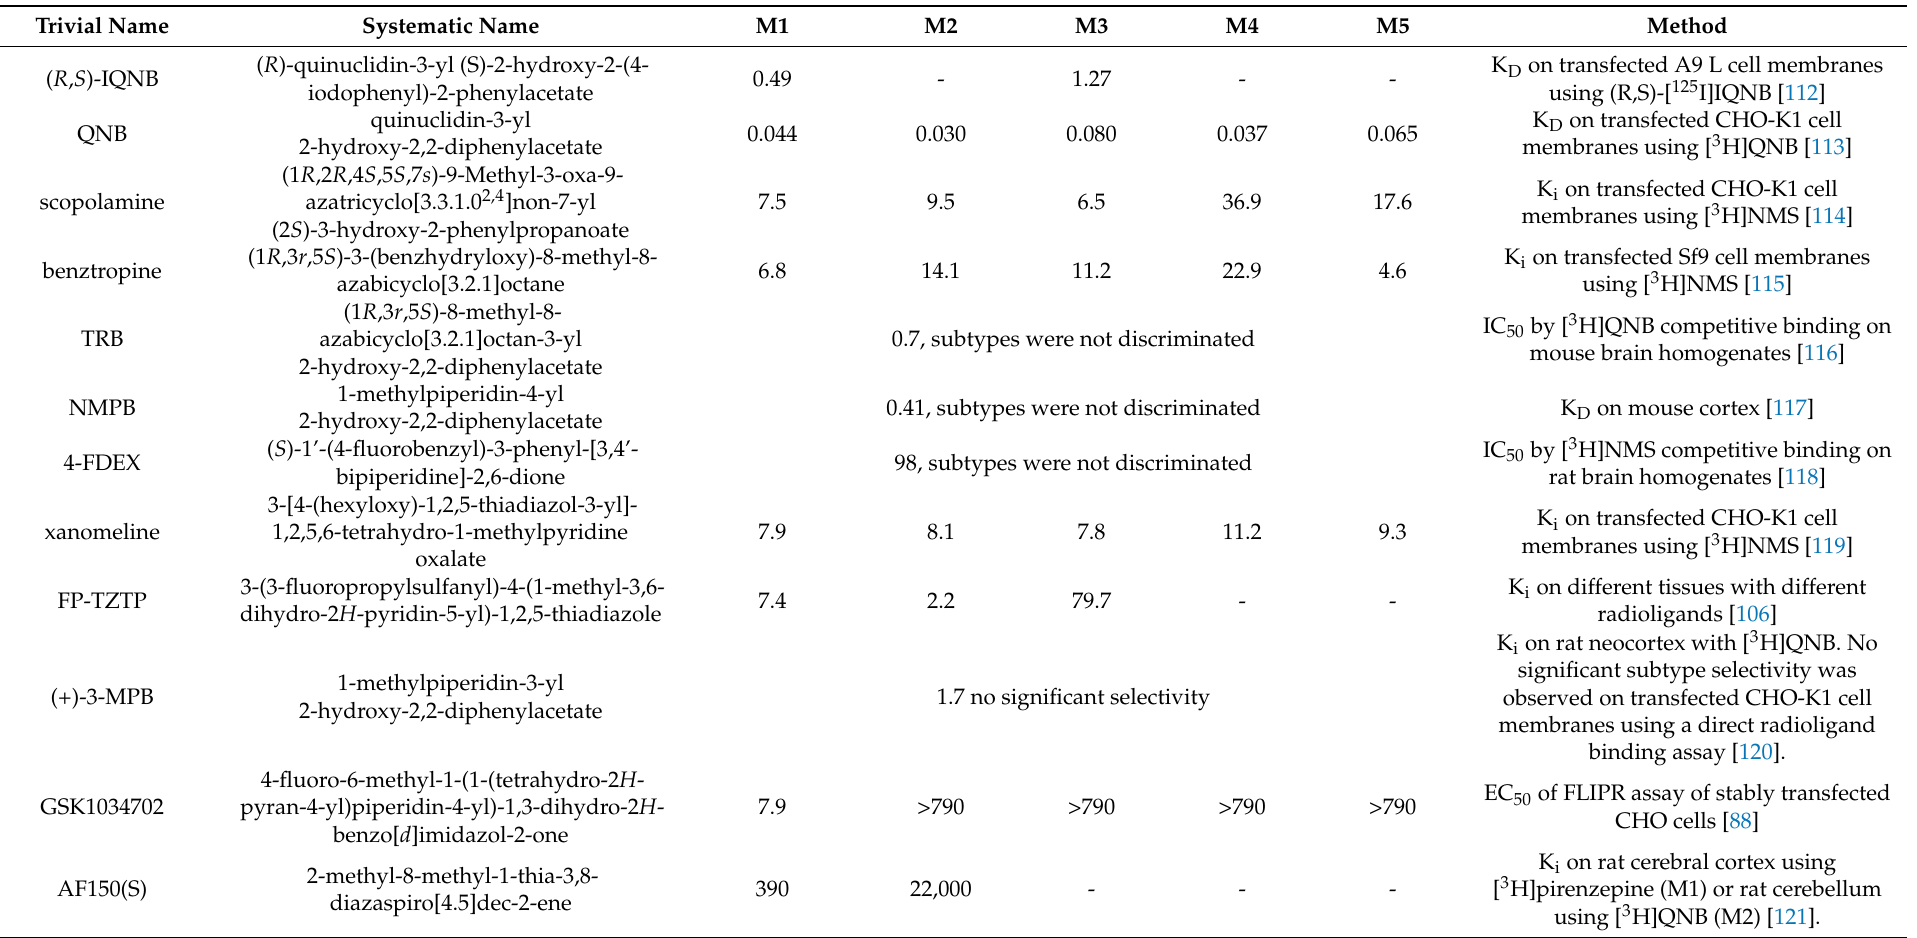
Table 3. Binding affinities of molecules shown in Figure 2. Values are given in nM. Wherever available K D /K i values on membranes of transfected cells are